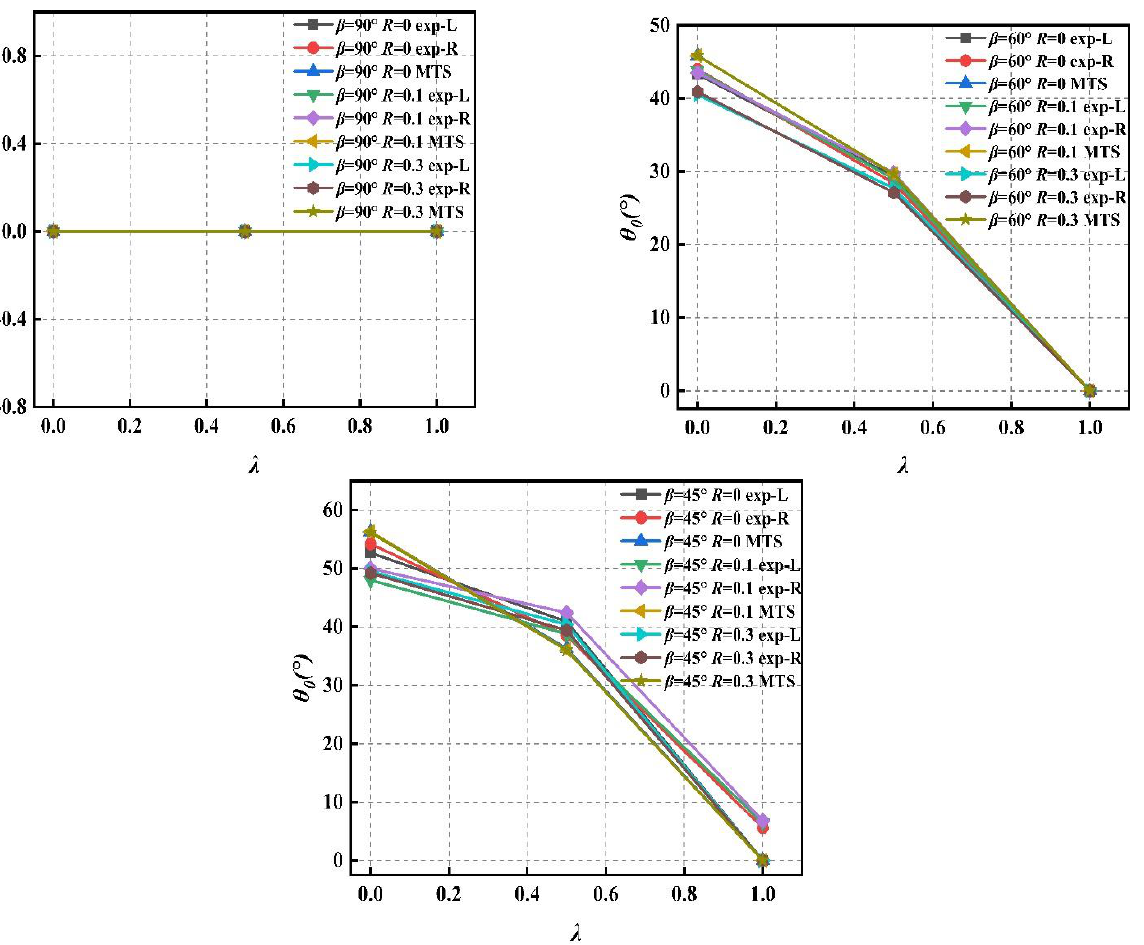
Figure 6. Comparison of experiment and predicted values for crack initiation